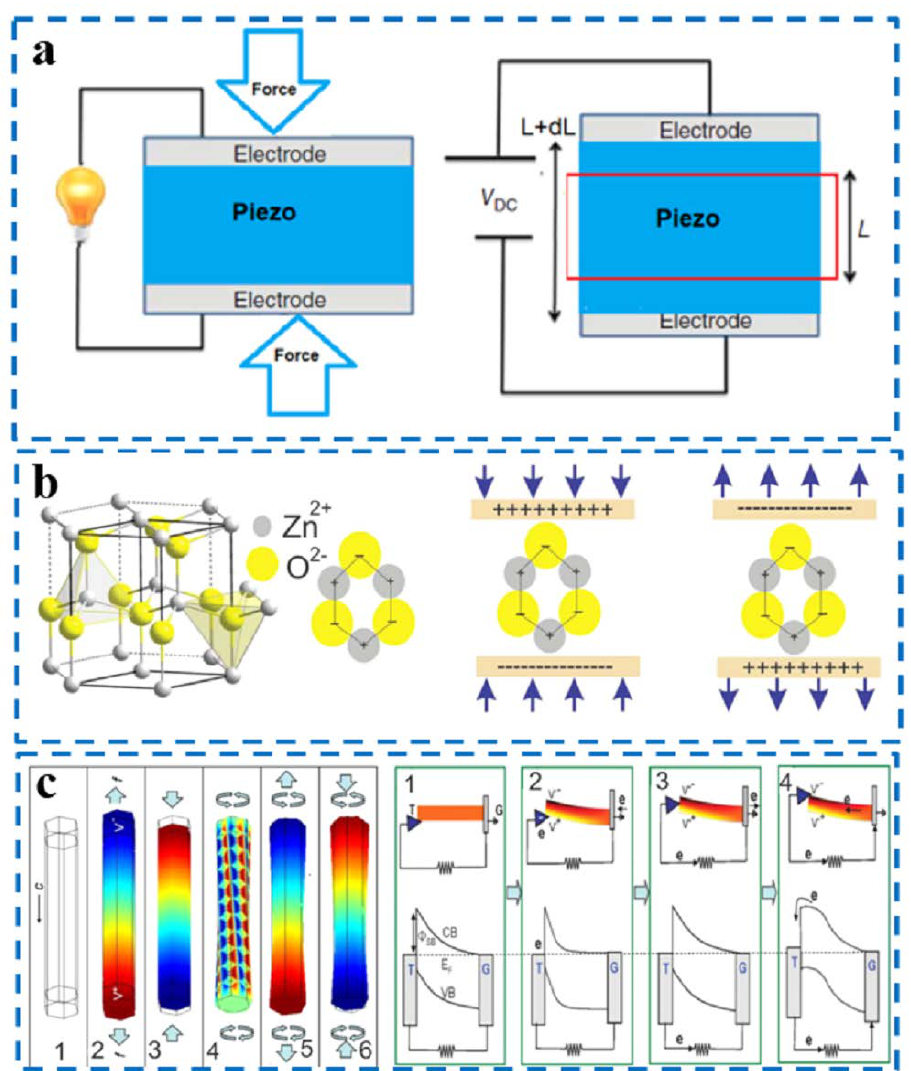
Figure 2. ( a ) Direct and reverse piezoelectric effects; ( b ) ZnO wurtzite structural model, with the piezoelectric potential in compression and tensile mode; ( c ) piezo-potential distribution in ZnO nanowires (left 1–6)and band diagrams in nanogenerators(right 1–4) [13].